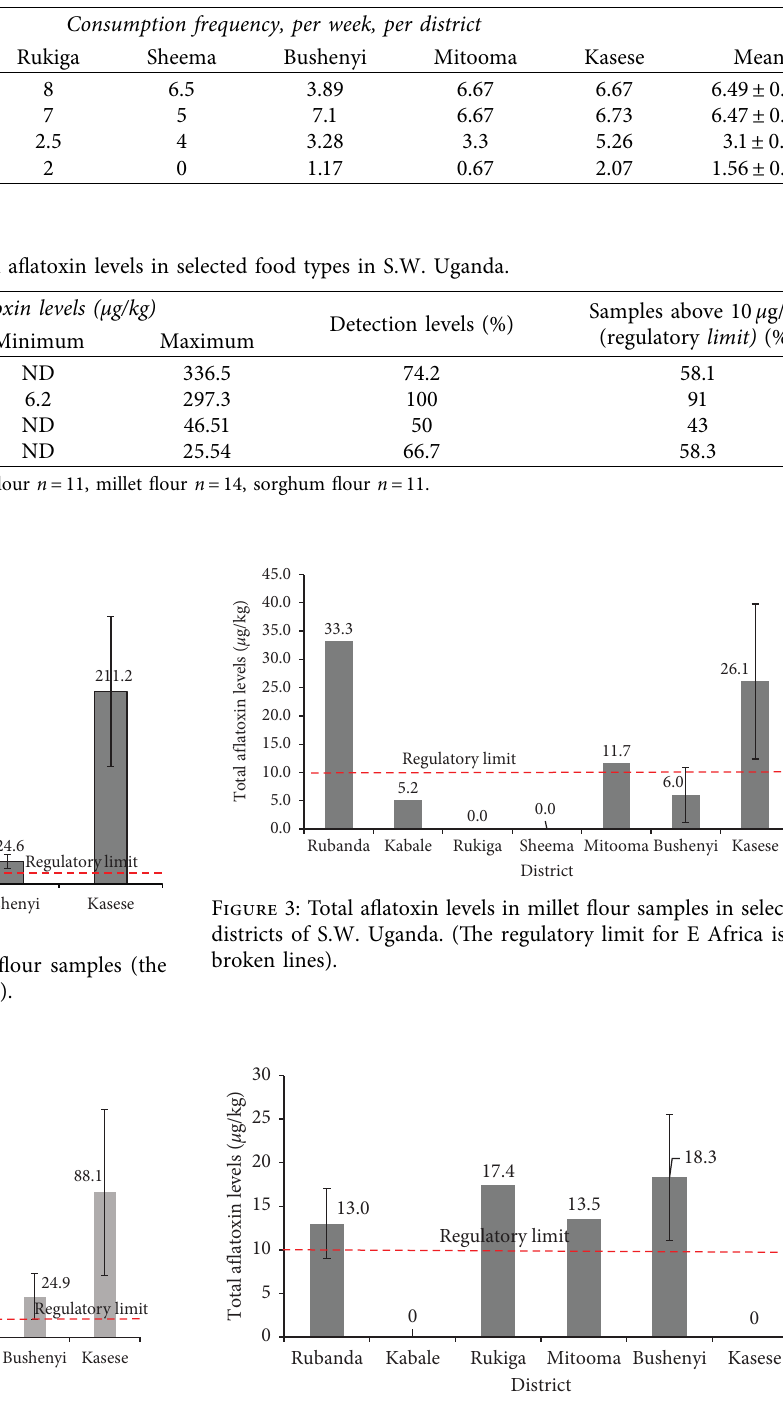
Table 1: Types of food and mean household consumption frequency per week, per district.